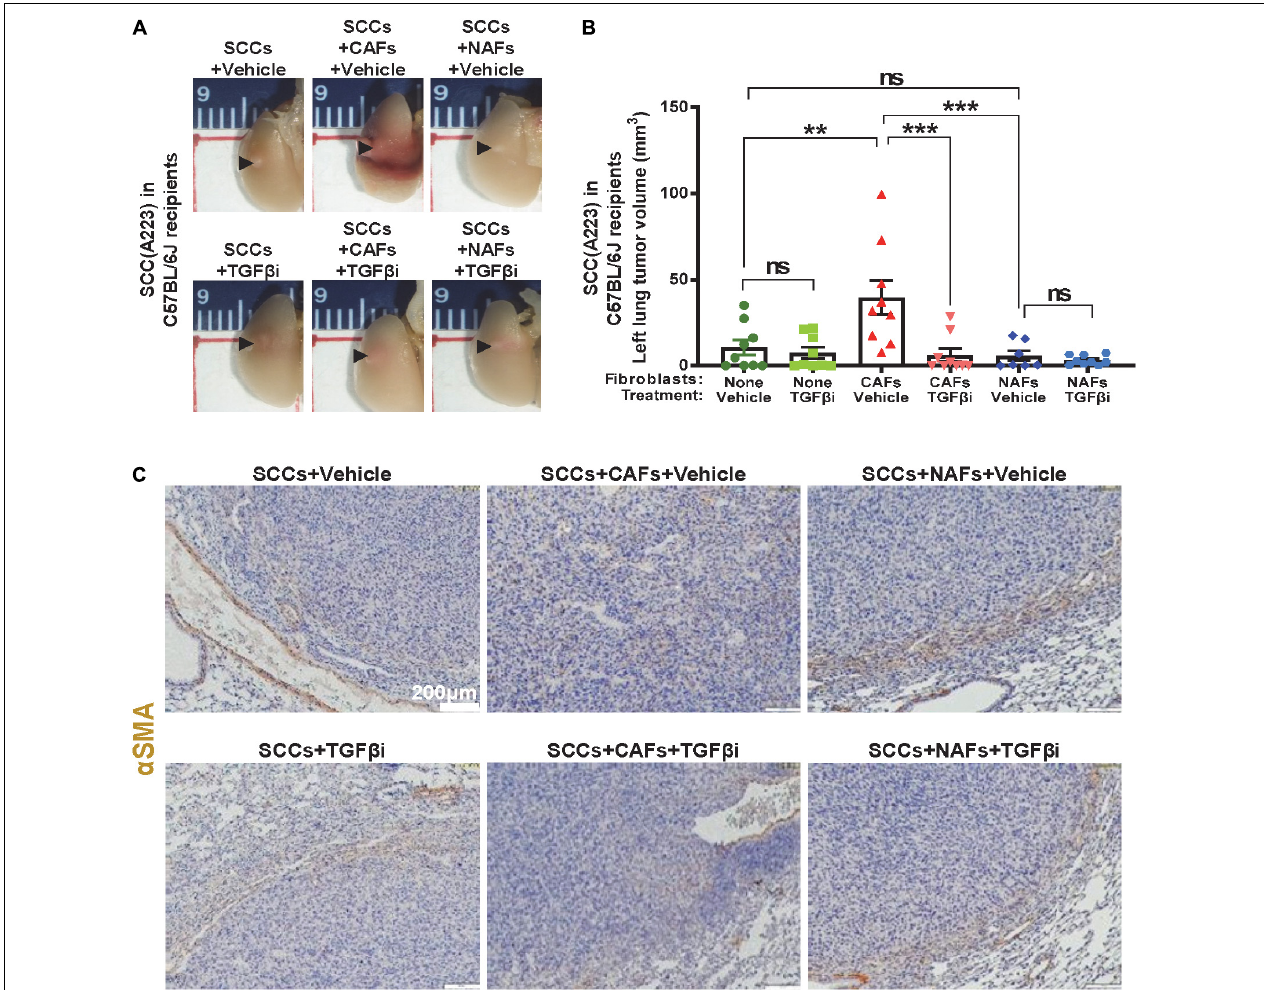
FIGURE 2 | Cancer-associated fibroblasts contributed to TGF β -dependent SCC seeding to the lung in immunocompetent recipients. (A) 1,000 A223 SCC cells and 5,000 of the indicated fibroblast types were co-transplanted to left lung, mice were treated daily with vehicle or TGF β inhibitor (“TGF β i”) LY2109761 and lungs were harvested on day 21 and imaged under 1 × magnification using a dissecting microscope. Representative gross images are presented. (B) Quantification of lung-seeded tumor volume (from gross samples) at the end point, ns P > 0.05, ** P < 0.01, *** P < 0.001. (C) Representative α SMA IHC stained